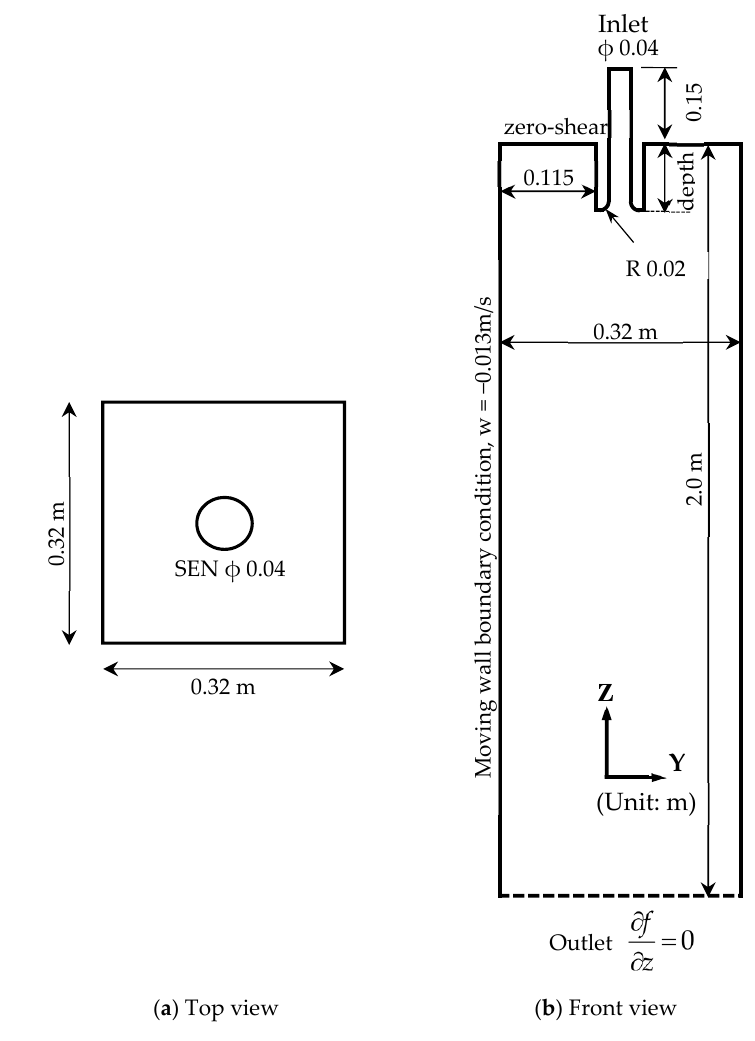
Figure 1. Geometry of the casting mold, ( a ) top view of the billet mold and ( b ) front view of the mold.